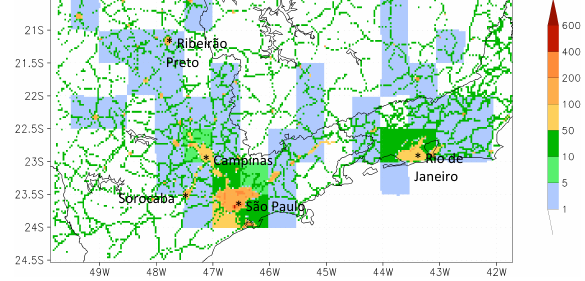
Fig. 7. CO emission rates (10 − 5 kgm − 2 day − 1 ) from Figure 7: CO emission rates (10 -5 kg m -2 day -1 ) from PREP-CHEM-SRC in the model PREP-CHEM-SRC in the model domain.